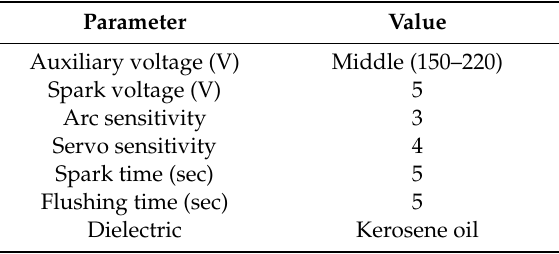
Table 5. List of constant parameters and their values.